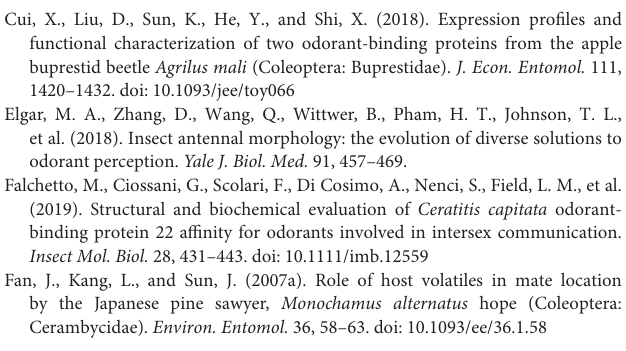
FIGURE S4 | Phylogenetic analysis of MaltOBP1 with other Coleopteran insects. MaltOBP1 is indicated in the arrows. The closest relative OBPs with MaltOBPs are highlighted with light pink color. The protein names and sequences of the 91 OBPs that were used included OBPs from Monochamus alternatus (Malt), Anoplophora glabripennis (Agla), Tribolium castaneum (Tcas), and Leptinotarsa decemlineata (Ldec). The accession numbers of genes used to construct phylogenetic tree are listed in Supplementary Table S2 , and the genes from L. decemlineata refer to Liu Y. et al. (2015) and Zhang et al. (2019). FIGURE S5 | Analysis of the size and purity of recombinant MaltOBP1 protein by LC-MS. TABLE S1 | Primers used in this study. TABLE S2 | The accession numbers of genes used to construct phylogenetic tree in this